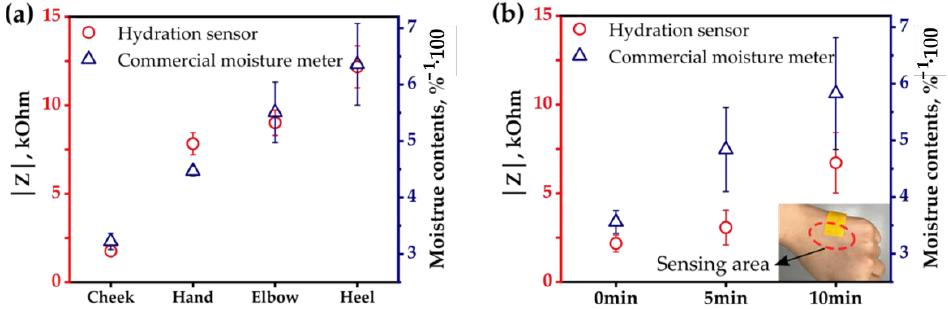
Figure 6. ( a ) Impedance of four different body parts. ( b ) Impedance of a hand after washing. The impedance is measured with the textile-based skin hydration sensor at a fixed frequency of 100 kHz and is plotted with the readings from a commercial moisture meter.